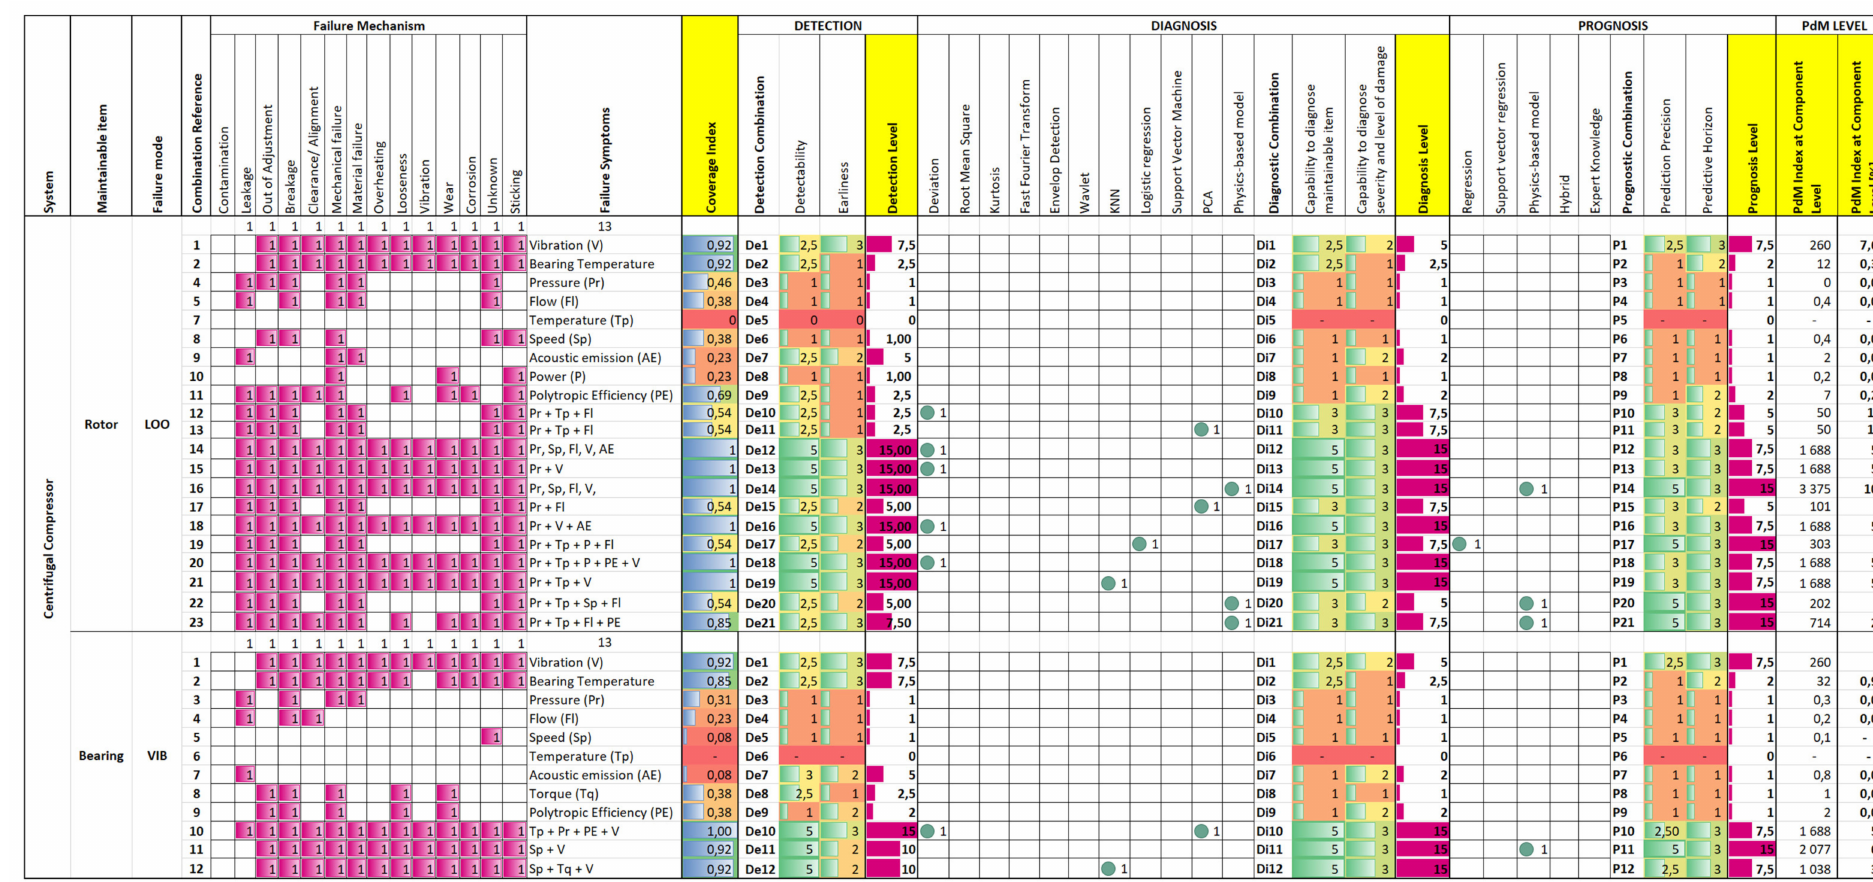
Figure 2. Snapshot of PdM assessment matrix for centrifugal compressors in Industry